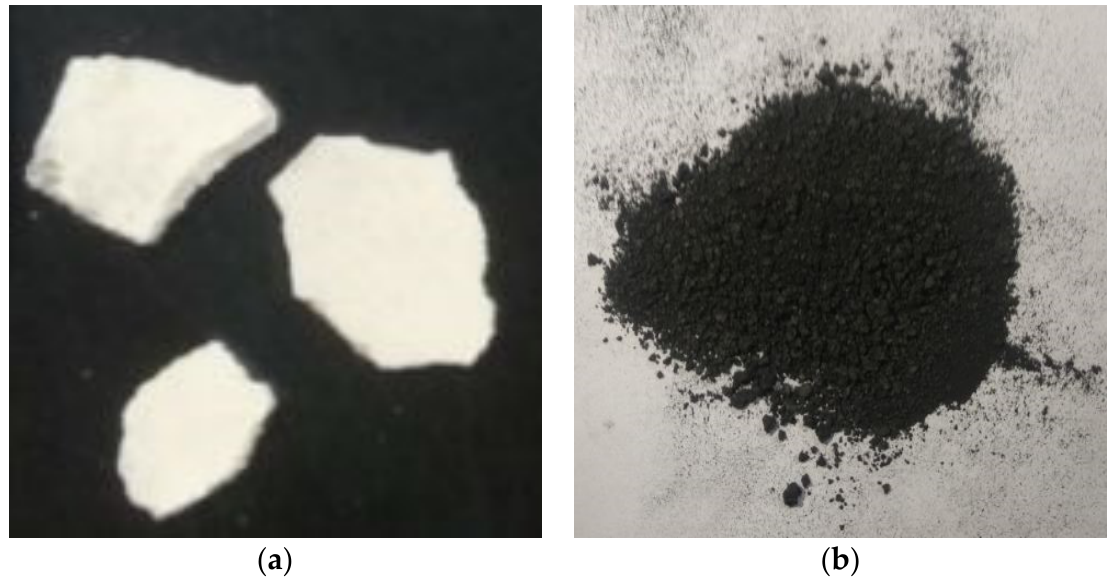
Figure 6. Specimen for the thermal conductivity experiment. ( a ) Block state; ( b ) powder state.